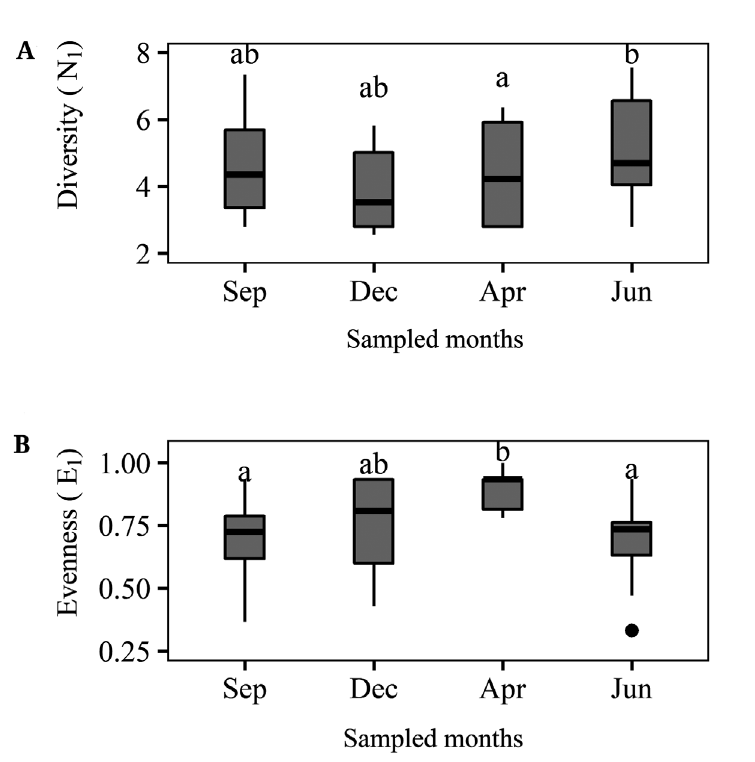
FIGURE 4 | Boxplots for diversity and evenness for the sampled months from September 1994 to June 1995. A. Diversity, B. Evennes. Line: median; box: 25th to 75th percentiles; whiskers: minimum to maximum value range. Differences in GLM p-values are shown by lowercase letters, different letters mean significant differences for the indexes (p-value <